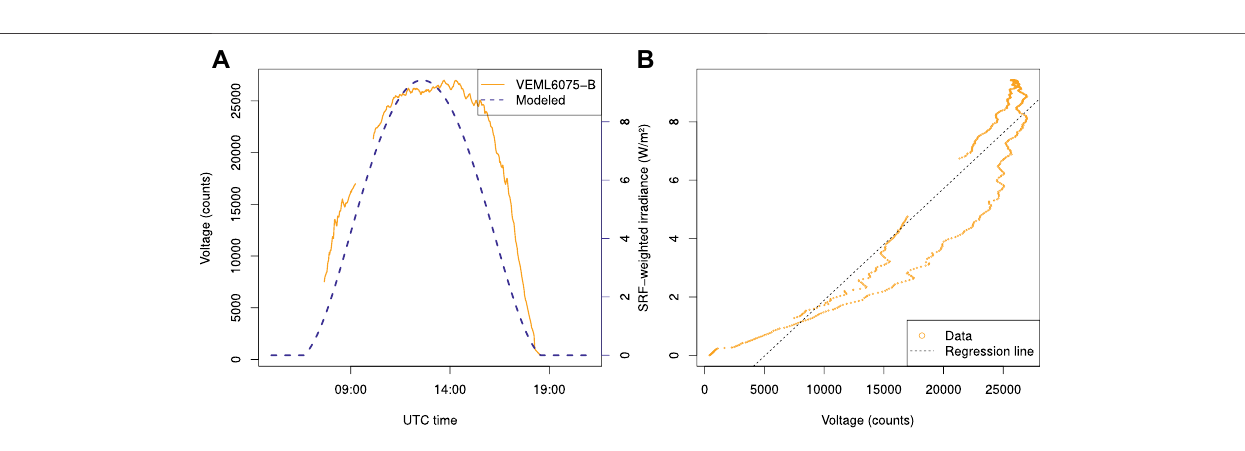
Frontiers in Environmental Science |